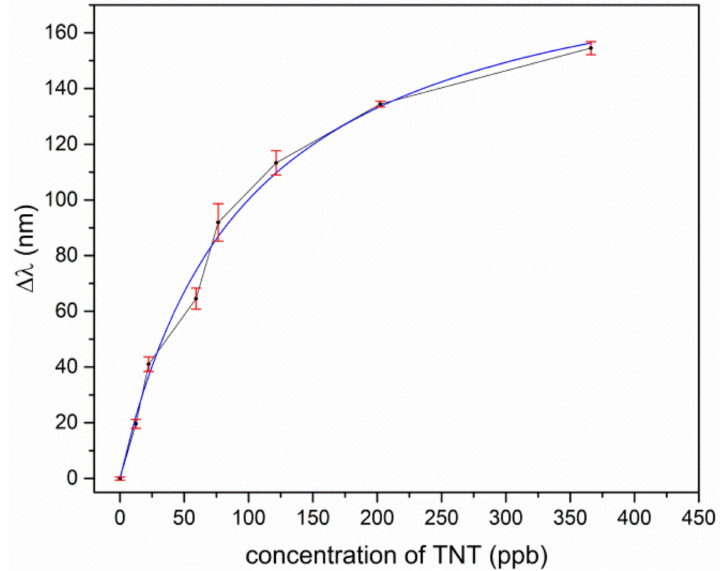
Figure 7. Shift of the resonant transmission minimum to a longer wavelength in dependence of TNT